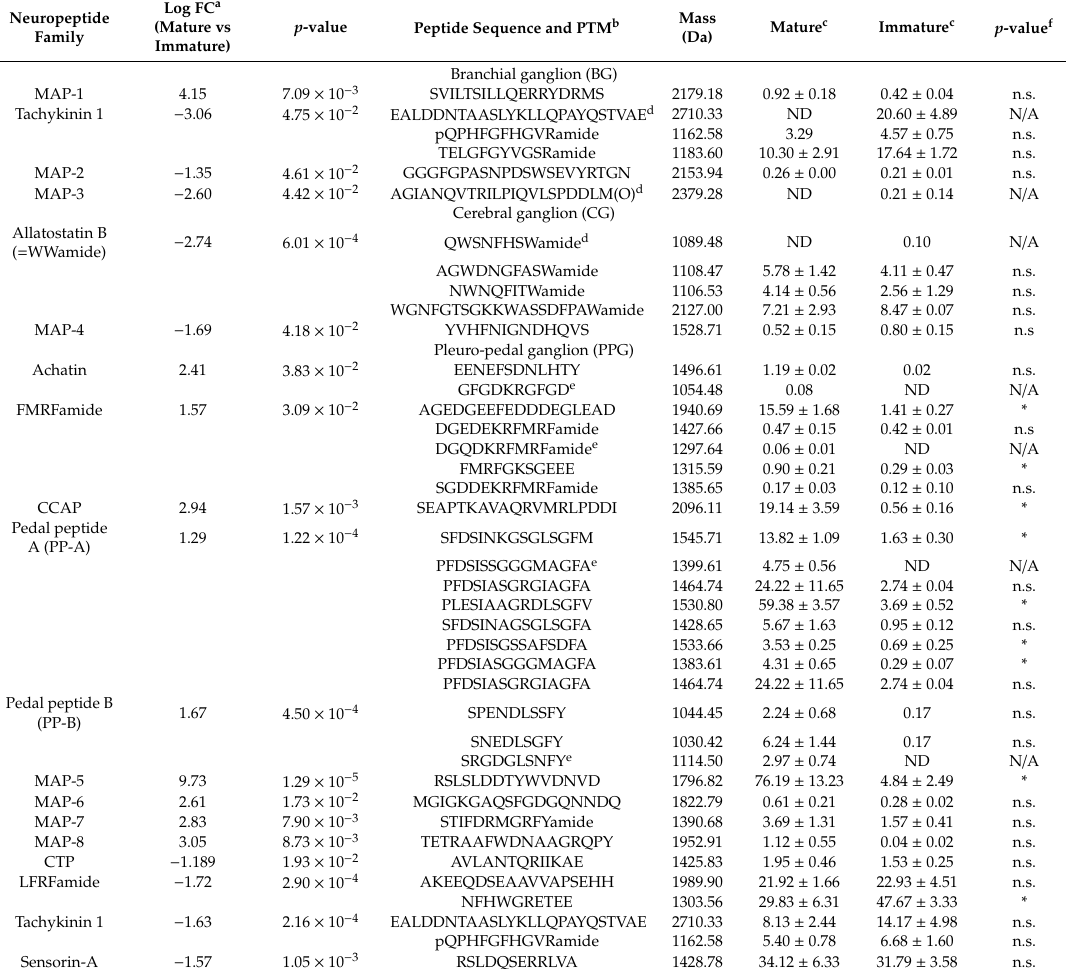
Table 3. List of neuropeptides up and downregulated in the ganglia of Haliotis discus hannai, as determined by mass spectrometry at immature and mature